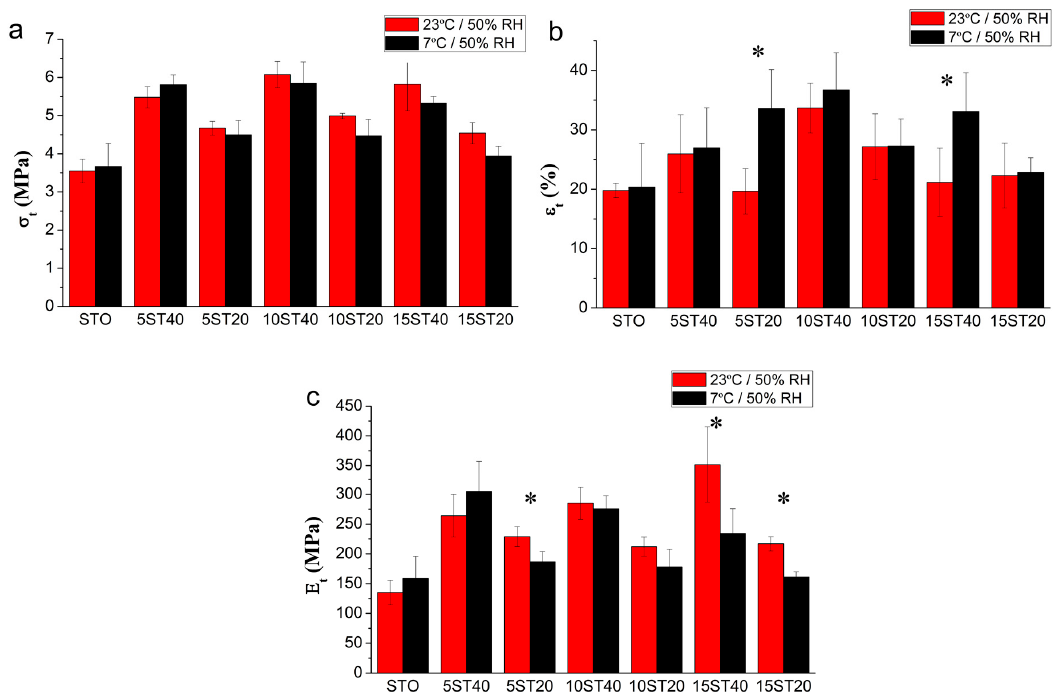
Figure 4. ( a ) Tensile strength ( σ t), ( b ) elongation at break ( ε t), and ( c ) Young’s modulus (Et) of